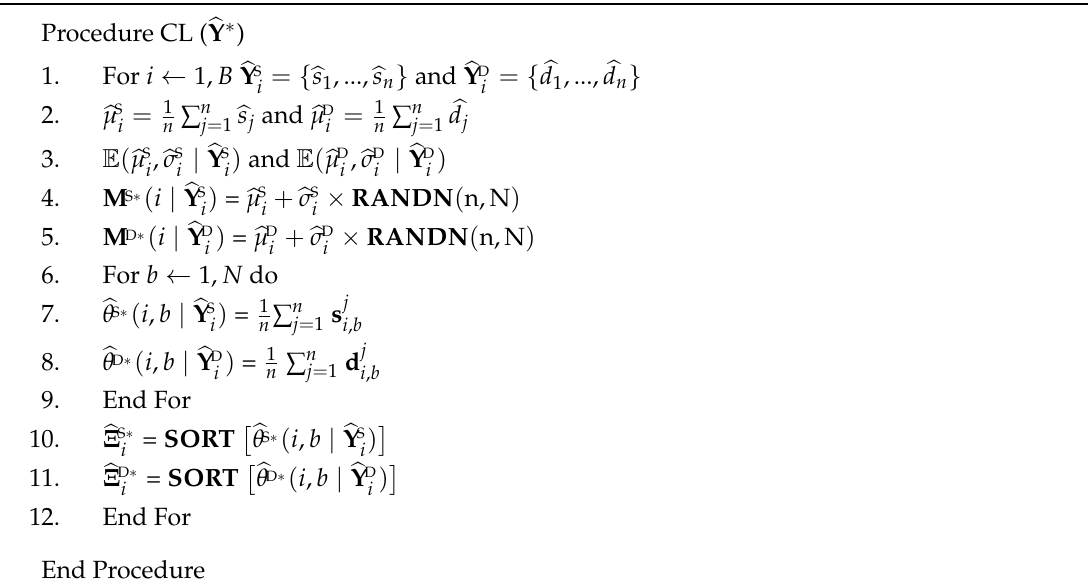
Algorithm 1: CL using bootstrap based on deep